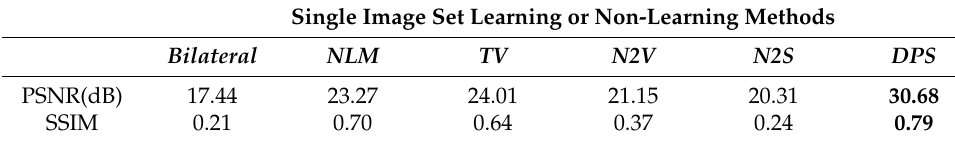
Table 2. Quantitative results from the lithium polymer dataset.